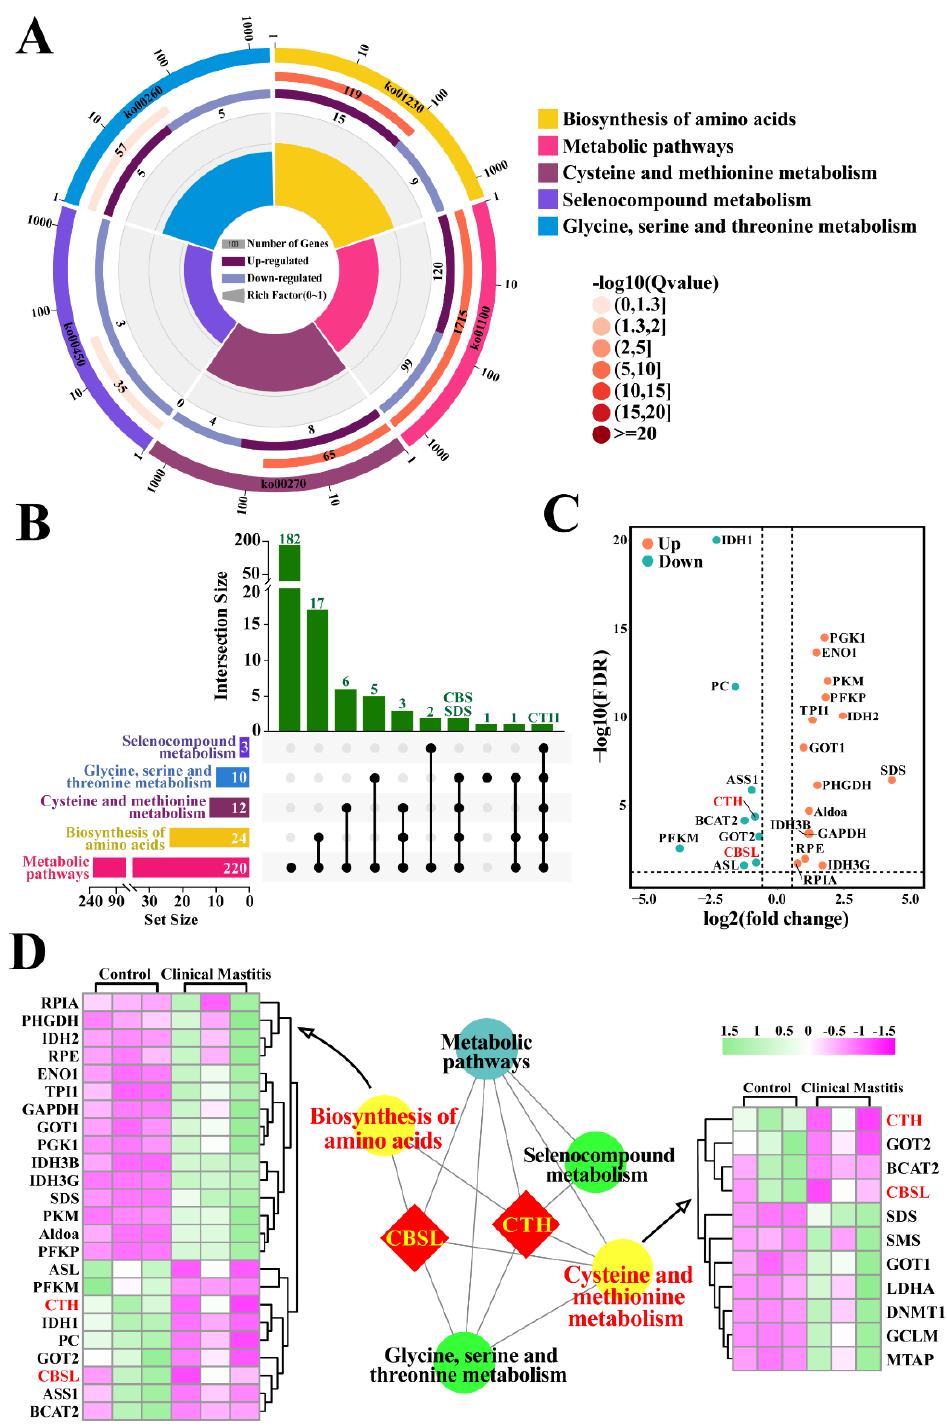
Figure 2. Identification of candidate DEPs and KEGG pathways related to sulfur metabolism. ( A ) Enrichment circle diagram of KEGG pathways related to sulfur metabolism. Color of the outermost layer represents the different KEGG classifications related to sulfur metabolism. Second layer contains information on the number of DEPs and the degree of significant enrichment. Third layer shows the upregulation and downregulation of DEPs. Fourth layer represents the enrichment factor for each pathway. ( B ) Upset-Venn diagram of five KEGG classifications related to sulfur metabolism. ( C ) Volcano plots of the 24 DEPs, including eight downregulated and 16 upregulated DEPs. ( D ) PPI network and heat map analysis of amino acid biosynthesis and cysteine and methionine